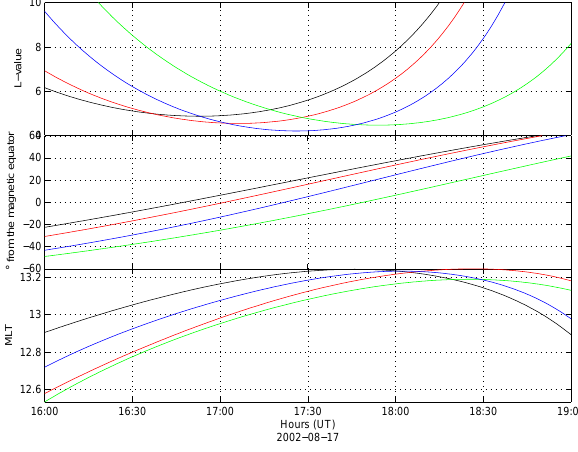
Fig. 4. L -value, polar angle in SM-coordinates and MLT for s/c 1 (black), s/c 2 (red), s/c 3 (green) and s/c 4 (blue) for the 17 August 2002